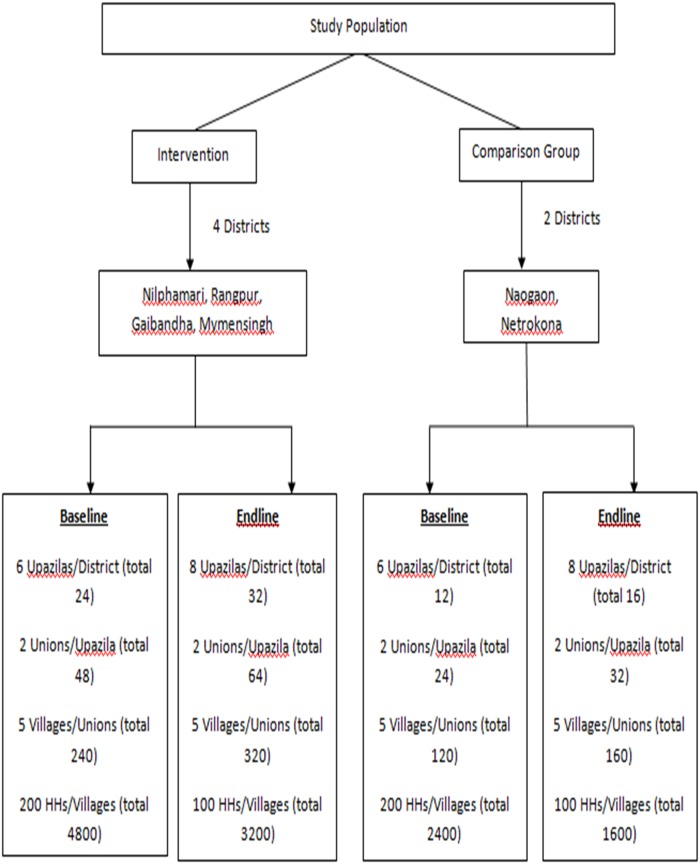
Study flow chart.